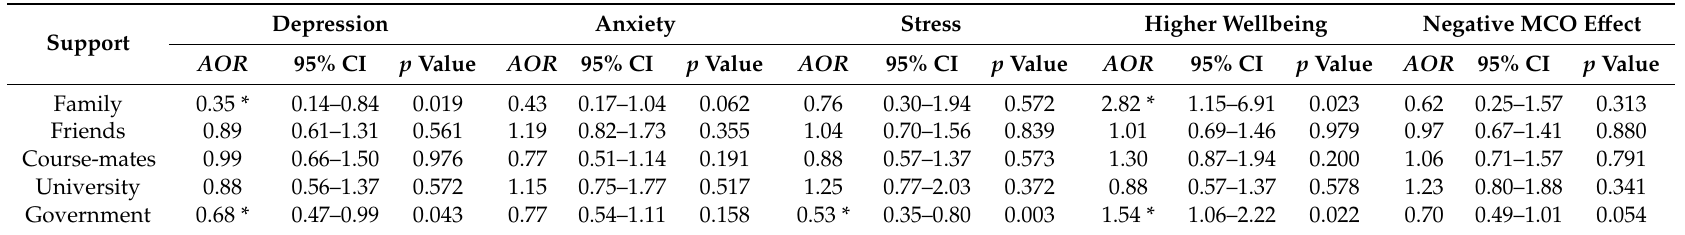
Table 6. Associations between types of support and depression, anxiety, stress, high mental wellbeing, and MCO’s negative e ff